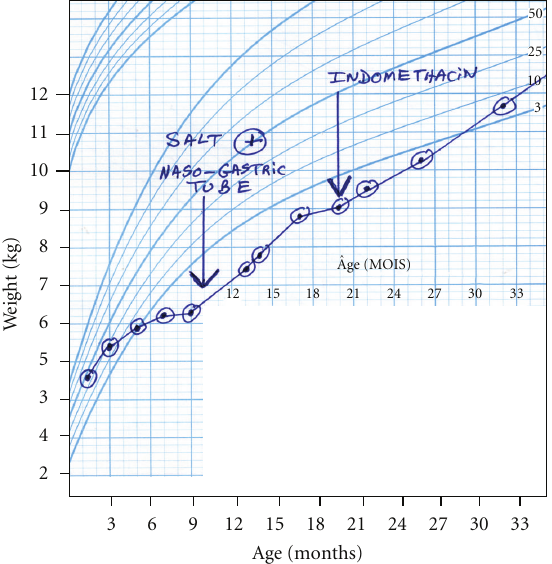
Figure 2: Growth curve for a cystinotic child. (1) Growth velocity fall o ff at 4–6 months of age improves with salt supplements and increased fluid volume delivered by a nasogastric tube. (2) Slowing of growth velocity at 17–19 months of age is improved by introduction of indomethacin to reduce electrolyte losses by 25–